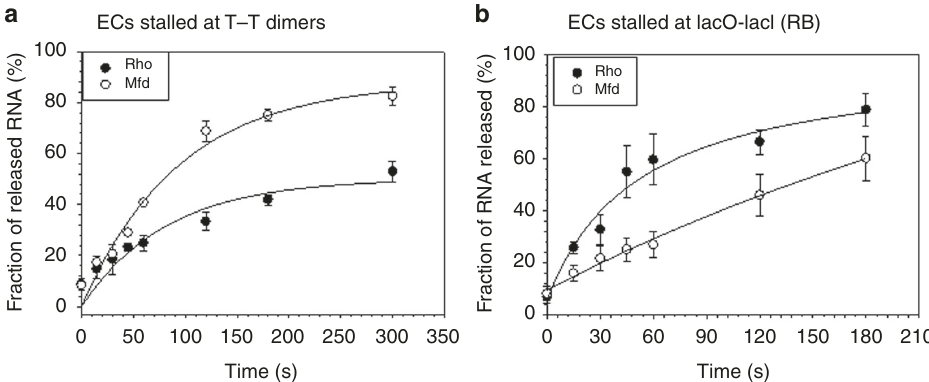
Fig. 6 Kinetics of Rho and Mfd induced RNA release from the stalled ECs at the T – T dimers : Fractions of either Rho-induced or Mfd-induced RNA released from the ECs stalled at the T – T dimers ( a ) or at a LacI-LacO road-block site ( b ) were plotted against the time. Curve fi ttings were performed by using exponential increase equation of the form, y = a (1 − e − bx ), where “ a ” is amplitude and “ b ” is the rate. The fraction of RNA release in ( a ) were calculated from the band intensities indicated by * in supplementary fi gure 6a, and those in ( b ) are from the RB bands in supplementary fi gure 6b. Error bars were calculated from the standard deviations obtained from at least three independent measurements. Source data are provided as a Source Data